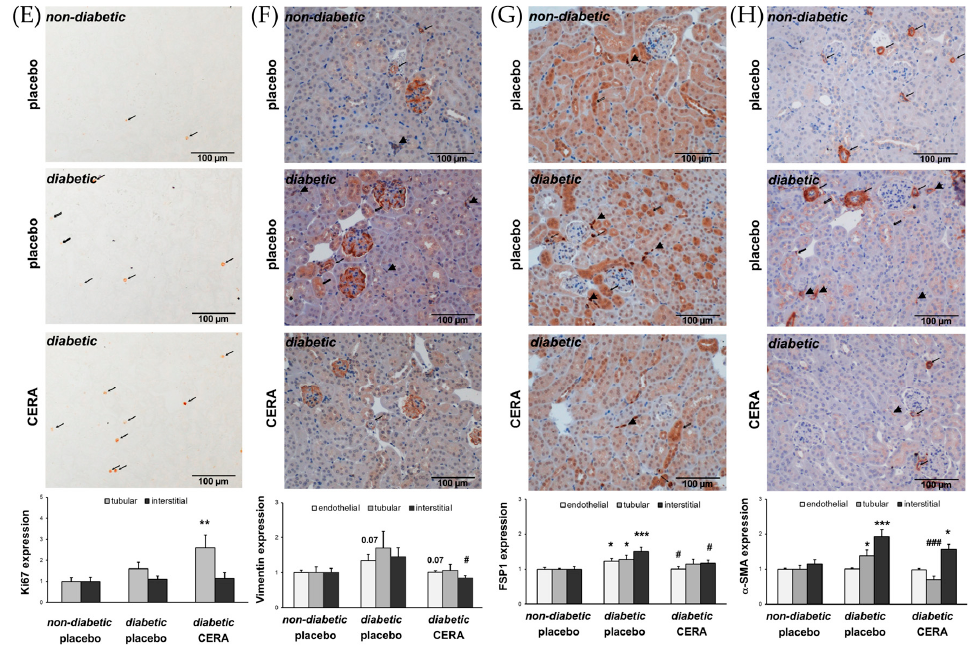
Figure 2. The sources of interstitial myofibroblasts are influenced in db / db mice. ( A ) Snail1. Representative images of Snail1 immunohistochemistry (magnification: 200 × ) and semi-quantitative analysis of the number of positively stained cells (graph); ( B ) MMP2. Representative images of MMP2 immunohistochemistry (magnification: 200 × ) and semi-quantitative analysis of the staining (graph); ( C ) E-cadherin. Representative images of E-cadherin immunohistochemistry (magnification: 200 × ) and semi-quantitative analysis of the staining (graph); ( D ) CD34. Representative images of CD34 immunohistochemistry (magnification: 200 × ) and semi-quantitative analysis of the number of positively stained interstitial cells (graph); ( E ) Ki67. Representative images of Ki67 immunohistochemistry (magnification: 200 × ) and semi-quantitative analysis of the number of positively stained nuclei of tubular (thin arrow) and interstitial cells (double thin arrow) (graph); ( F ) Vimentin. Representative images of vimentin immunohistochemistry (magnification: 200 × ) and semi-quantitative analysis of the endothelial and tubular staining as well as the number of positively stained interstitial cells (graph). Positive endothelial cells (thin arrow), positive tubular cells (double thin arrow), and positive interstitial cells (thick arrow); ( G ) FSP1. Representative images of FSP1 immunohistochemistry (magnification: 200 × ) and semi-quantitative analysis of the endothelial and tubular staining as well as the number of positively stained interstitial cells (graph). Positive endothelial cells (thin arrow), positive tubular cells (double thin arrow), and positive interstitial cells (thick arrow); ( H ) α -SMA. Representative images of α -SMA immunohistochemistry (magnification: 200 × ) and semi-quantitative analysis of the endothelial and tubular staining as well as the number of positively stained interstitial cells (graph). Positive endothelial cells (thin arrow), positive tubular cells (double thin arrow), and positive interstitial cells (thick arrow). The interstitial matrix-producing myofibroblasts are reduced in diabetic kidneys when treated with CERA. This is partly due to reduction of EMT-like or EndMT-like changes and less migration of fibrocytes into the interstitium. CERA also increases the proliferation rate of tubular cells. * p ≤ 0.05, ** p ≤ 0.01, *** p ≤ 0.001 = diabetic vs. non-diabetic control; # p ≤ 0.05, ### p ≤ 0.001 = db / db CERA vs. db / db placebo. The non-diabetic controls were assigned as an arbitrary value of